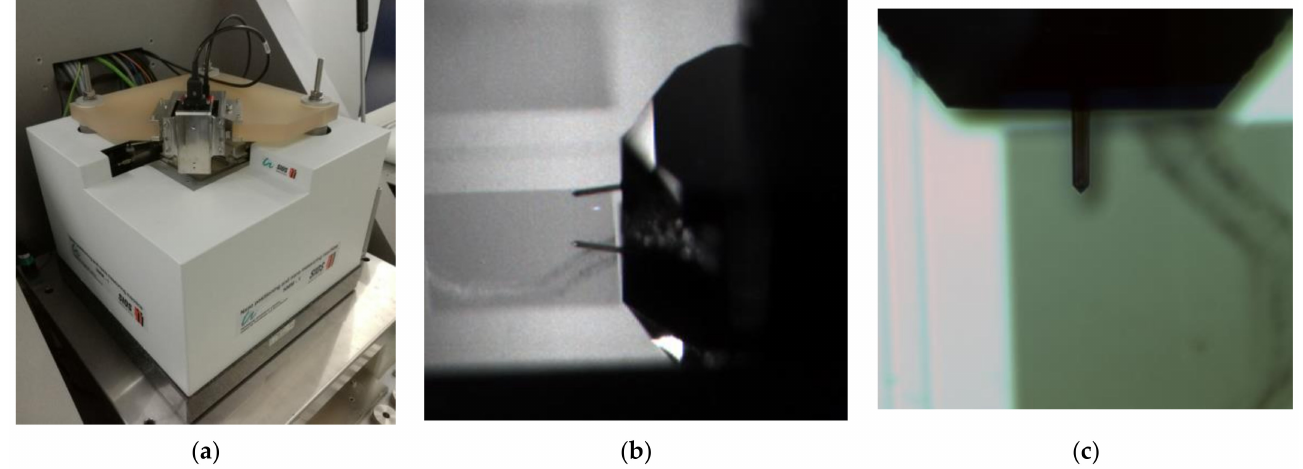
Figure 8. The AFM measurement system: ( a ) Mechanical integration; ( b ) Side view; ( c ) Top